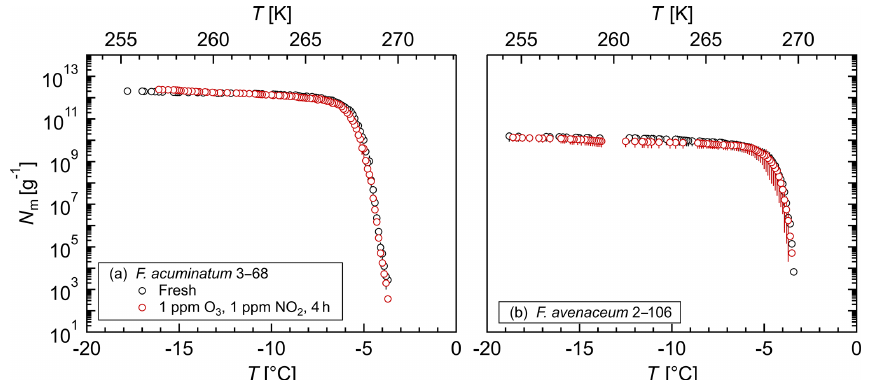
Figure 3. Exposure of aqueous extract from Fusarium to ozone and nitrogen dioxide: cumulative number of IN ( N m ) per mass of mycelium plotted against the temperature ( T ) for (a) F. acuminatum 3–68 and (b) F. avenaceum 2–106; arithmetic mean values and standard error of two independent experiments with aqueous extracts from two individual fungal culture plates of the same